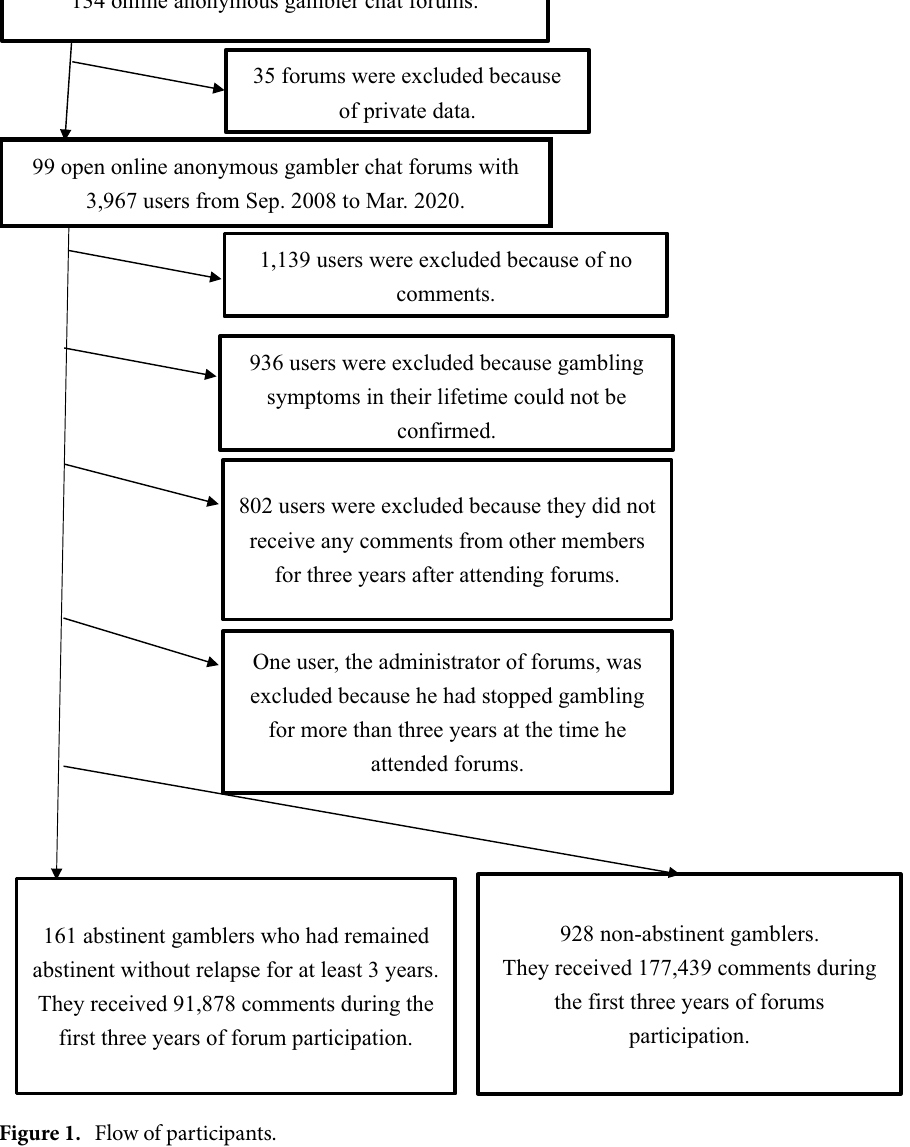
Figure 1. Flow of